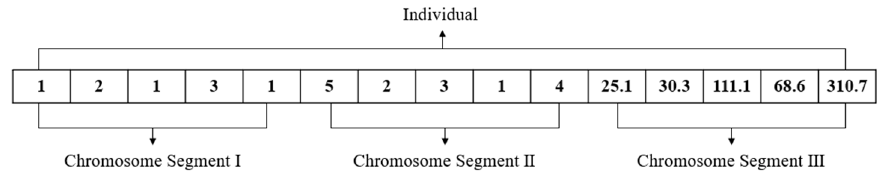
Figure 2. An example for encoding method of main task.